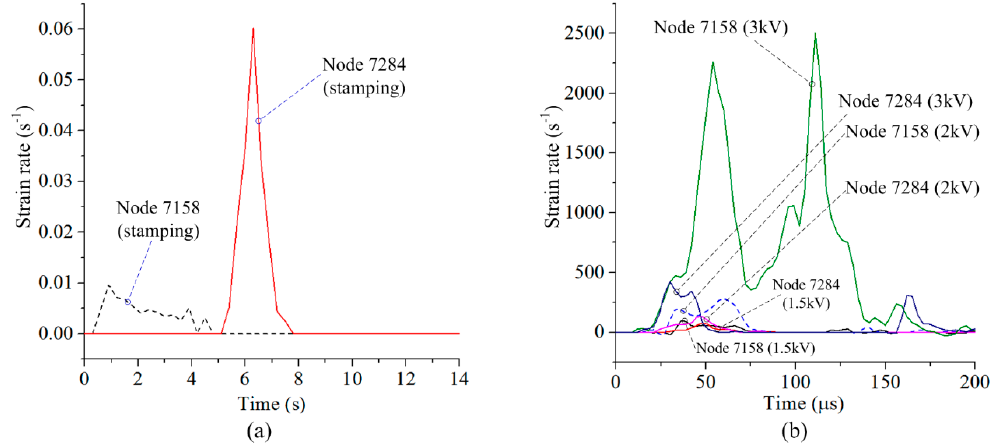
Figure 14. Strain rate versus time for ( a ) quasi-static stamping, and ( b ) coil discharge with di ff erent voltages.